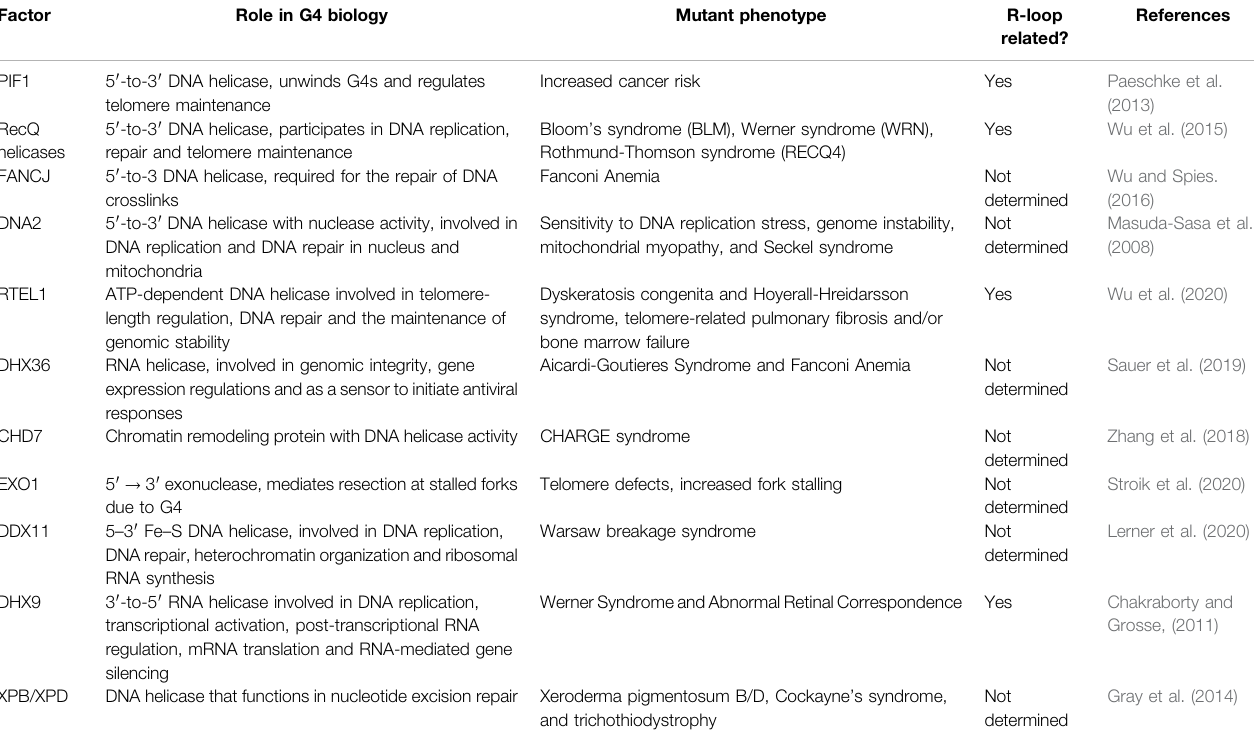
TABLE 2 | Helicases involved in G-quadruplexes resolution and their connection with R-loop biology. Factor